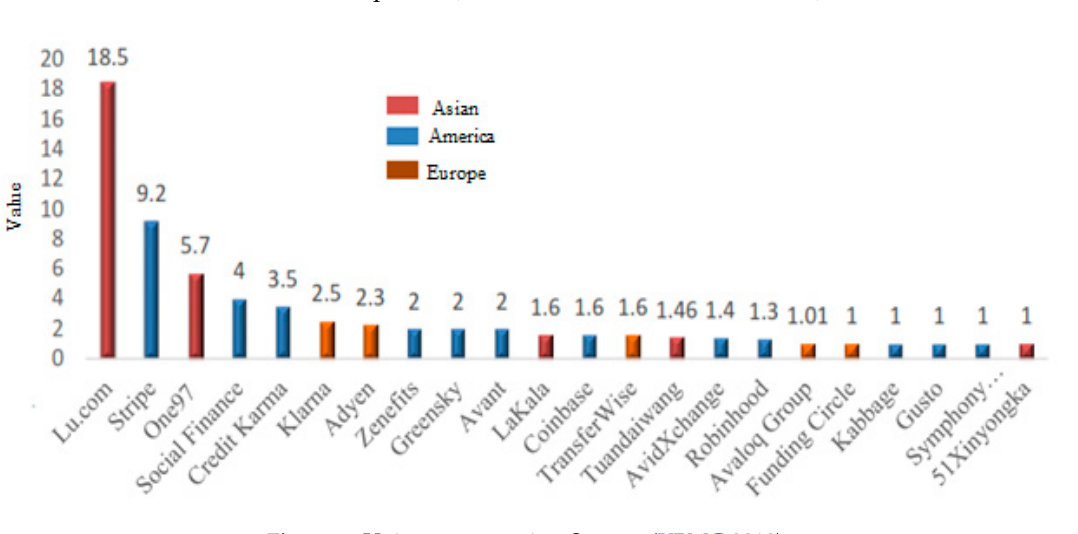
Figure 9. Unicorn companies. Source: (KPMG 2018).